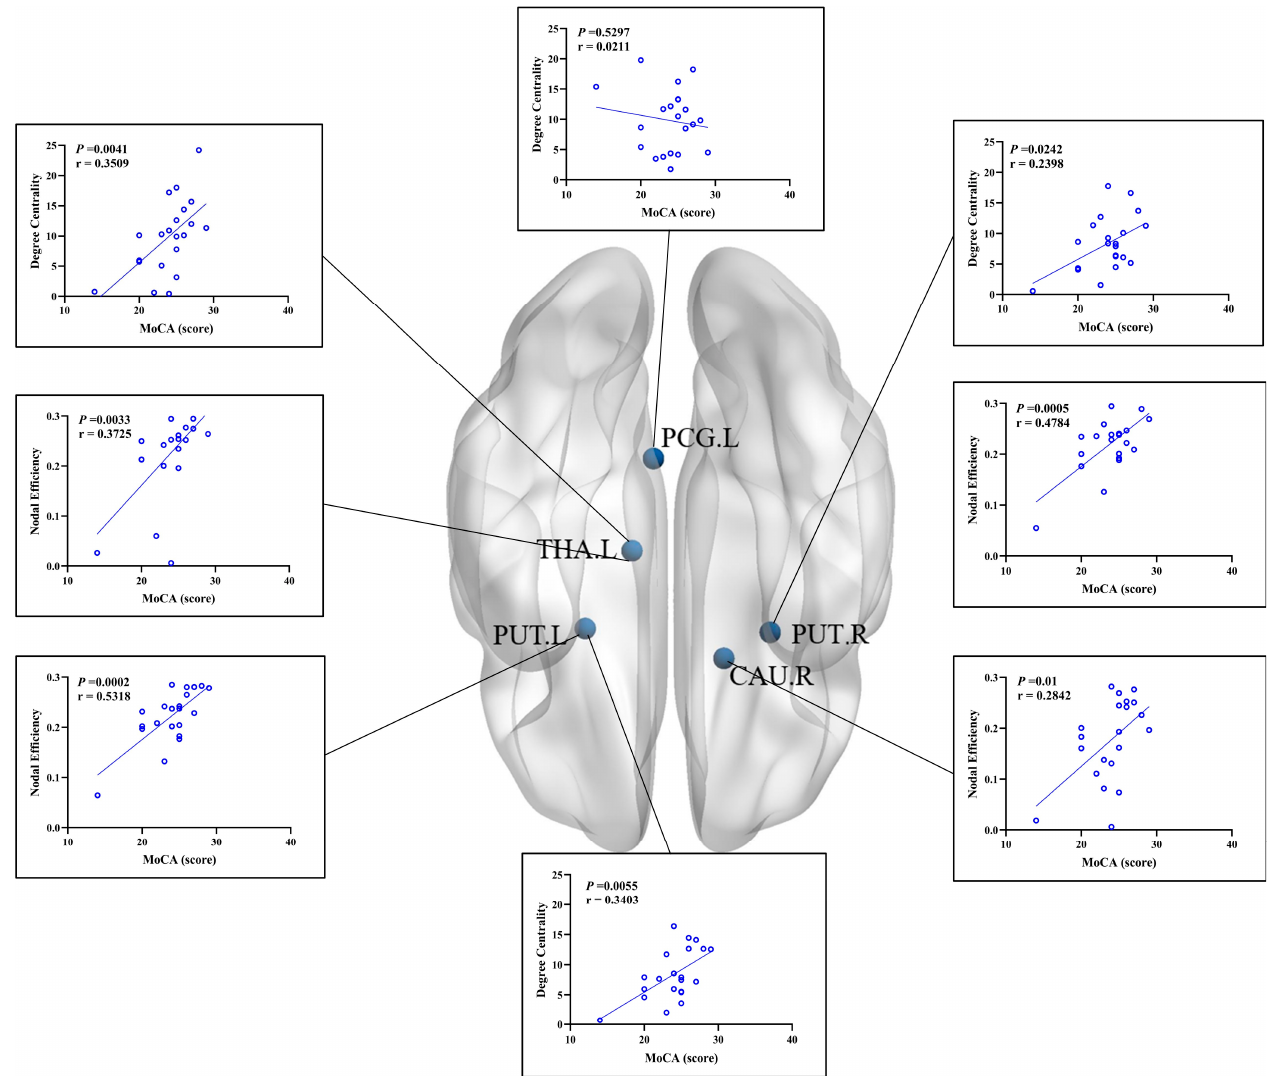
Figure 5. Scatter plot showing the correlation between node attributes and neuropsychological tests in CKD5 ND patients. PCG.L, posterior cingulate gyrus; THA.L, thalamus; CAU, caudate nucleus; PUT, lenticular nucleus, putamen; L, left; R, right; MoCA, Montreal Cognitive Assessment.